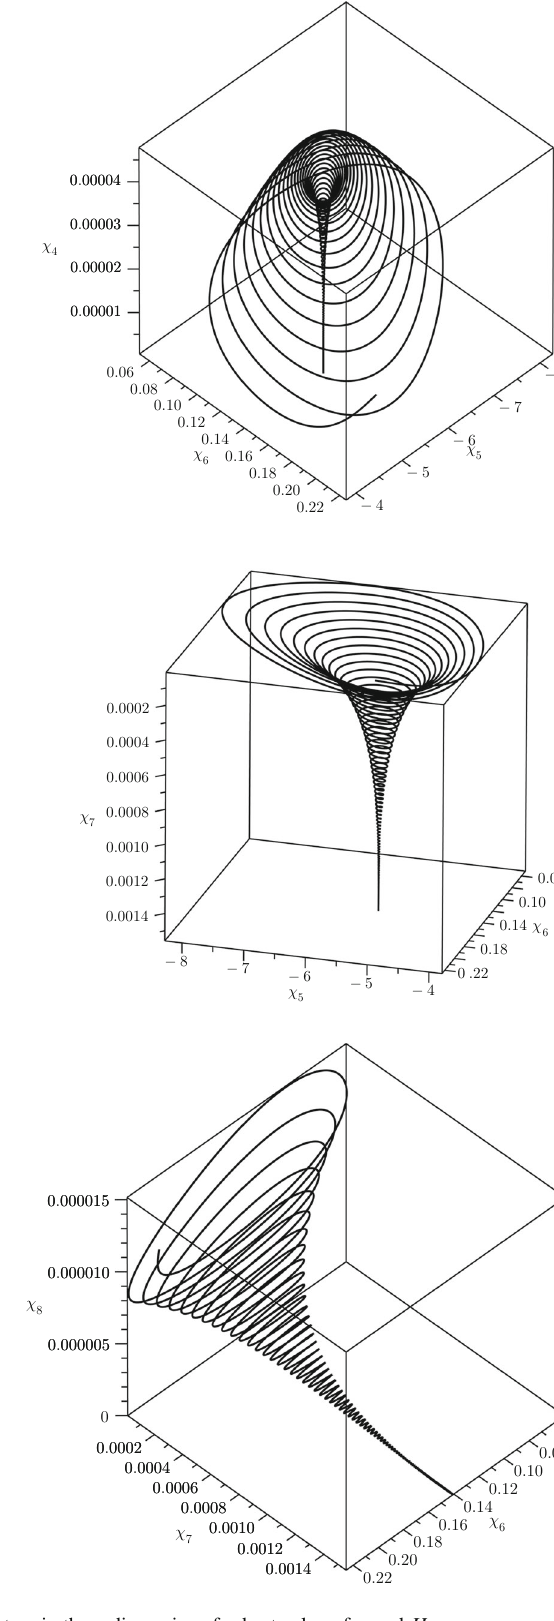
Fig. 2 Attractor behavior and small fluctuation in dynamics of the system in three dimensions for best value of α and H